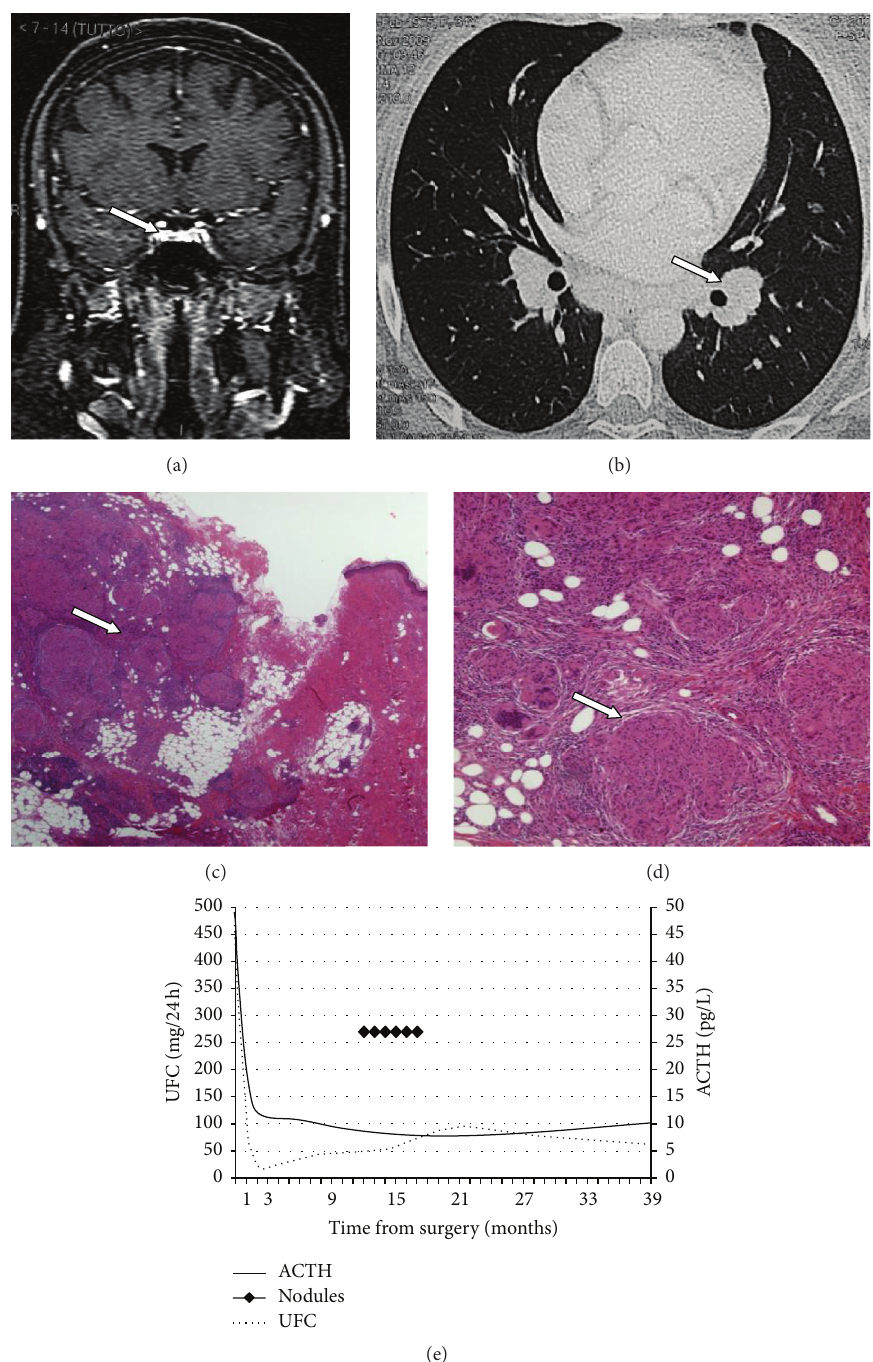
Figure 1: (a) Coronal MRI scan showing the pituitary microadenoma. (b) CT scan: multiple enlarged lymph nodes in the hilar-mediastinal region bilaterally. (c) 25x magnification: hematoxylin and eosin. Presence in the deep dermis and hypodermis of numerous epithelioid granulomas. (d) 100x magnification: hematoxylin and eosin. (e) Urinary free cortisol (UFC) and adrenocorticotropic hormone (ACTH) levels trend. Sarcoidosis nodules were present approximately from the 12th to the 17th month after